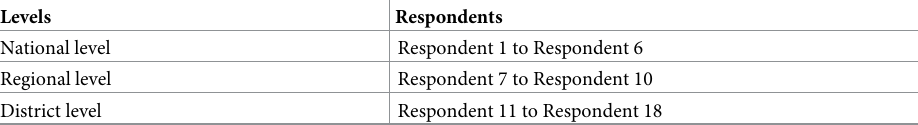
Table 1. Respondents distribution.